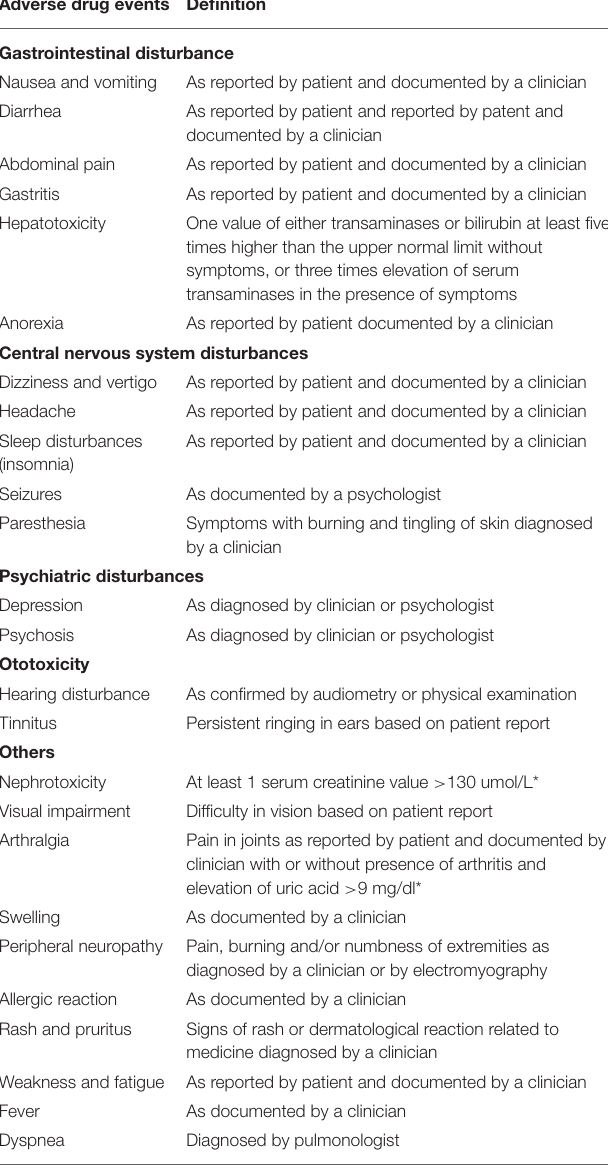
TABLE 1 | Identification of adverse drug